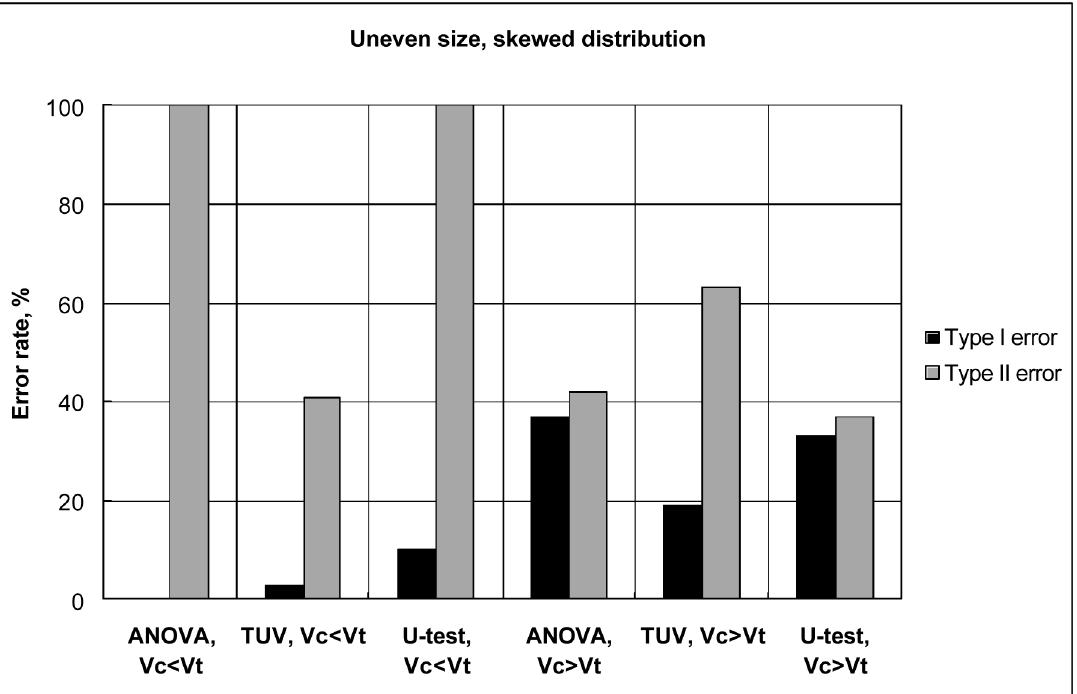
Fig. 4. Performance of statistical tests with skewed samples of uneven size and unequal variance. ANOVA stands for analysis of vari- ance, TUV for t-test for unequal variances, and U-test for Mann–Whitney U-test. Vc and Vt refer to the variance of the control and treatment groups